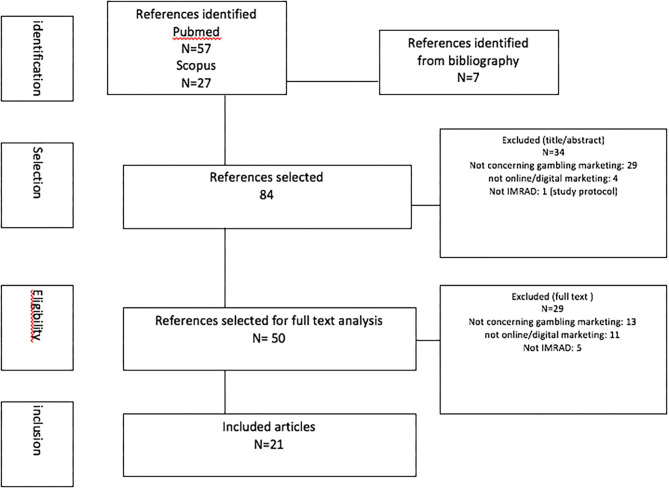
PRISMA flowchart.